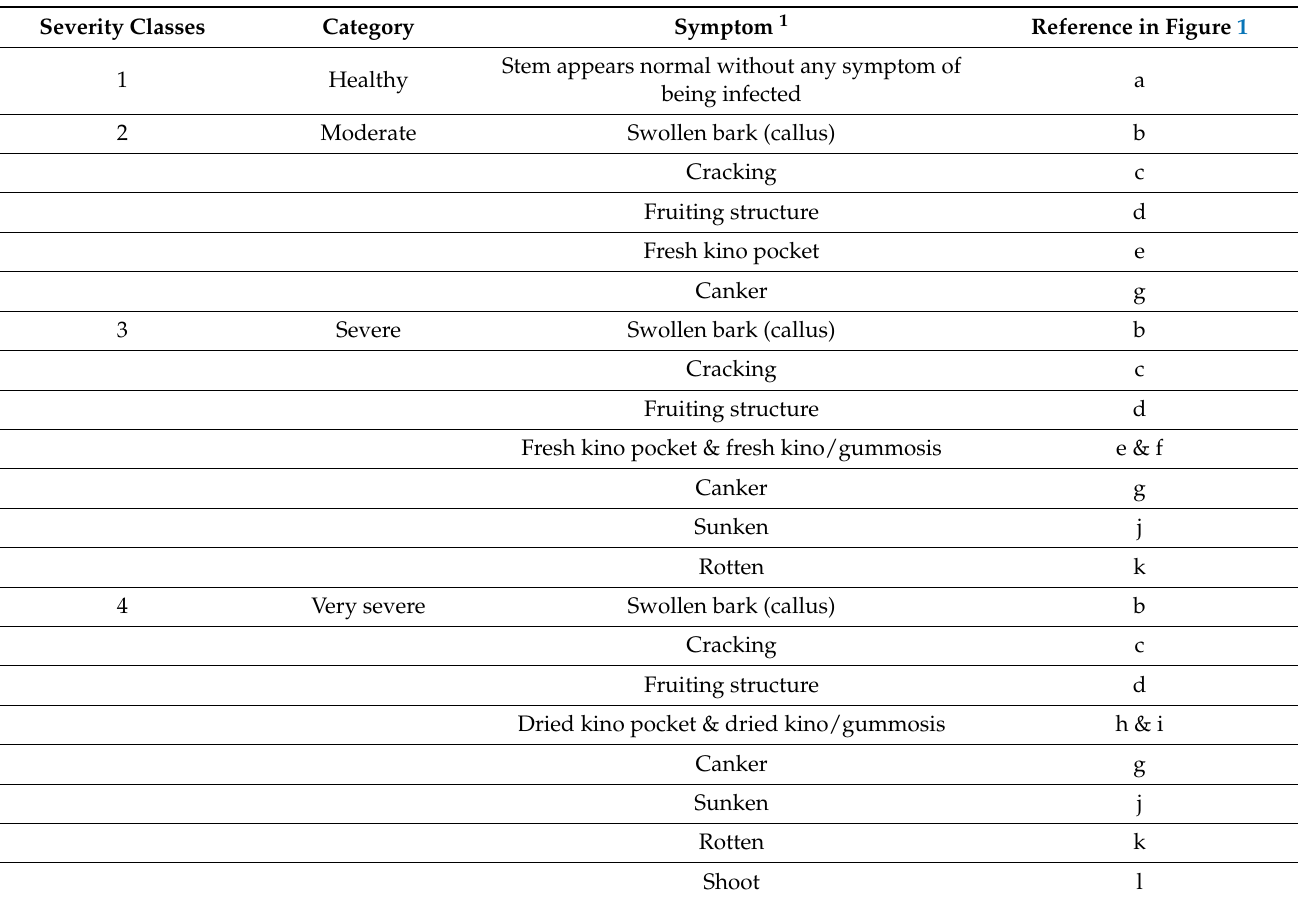
Table 1. Severity classes for Eucalyptus urograndis infected by Chrysoporthe deuterocubensis